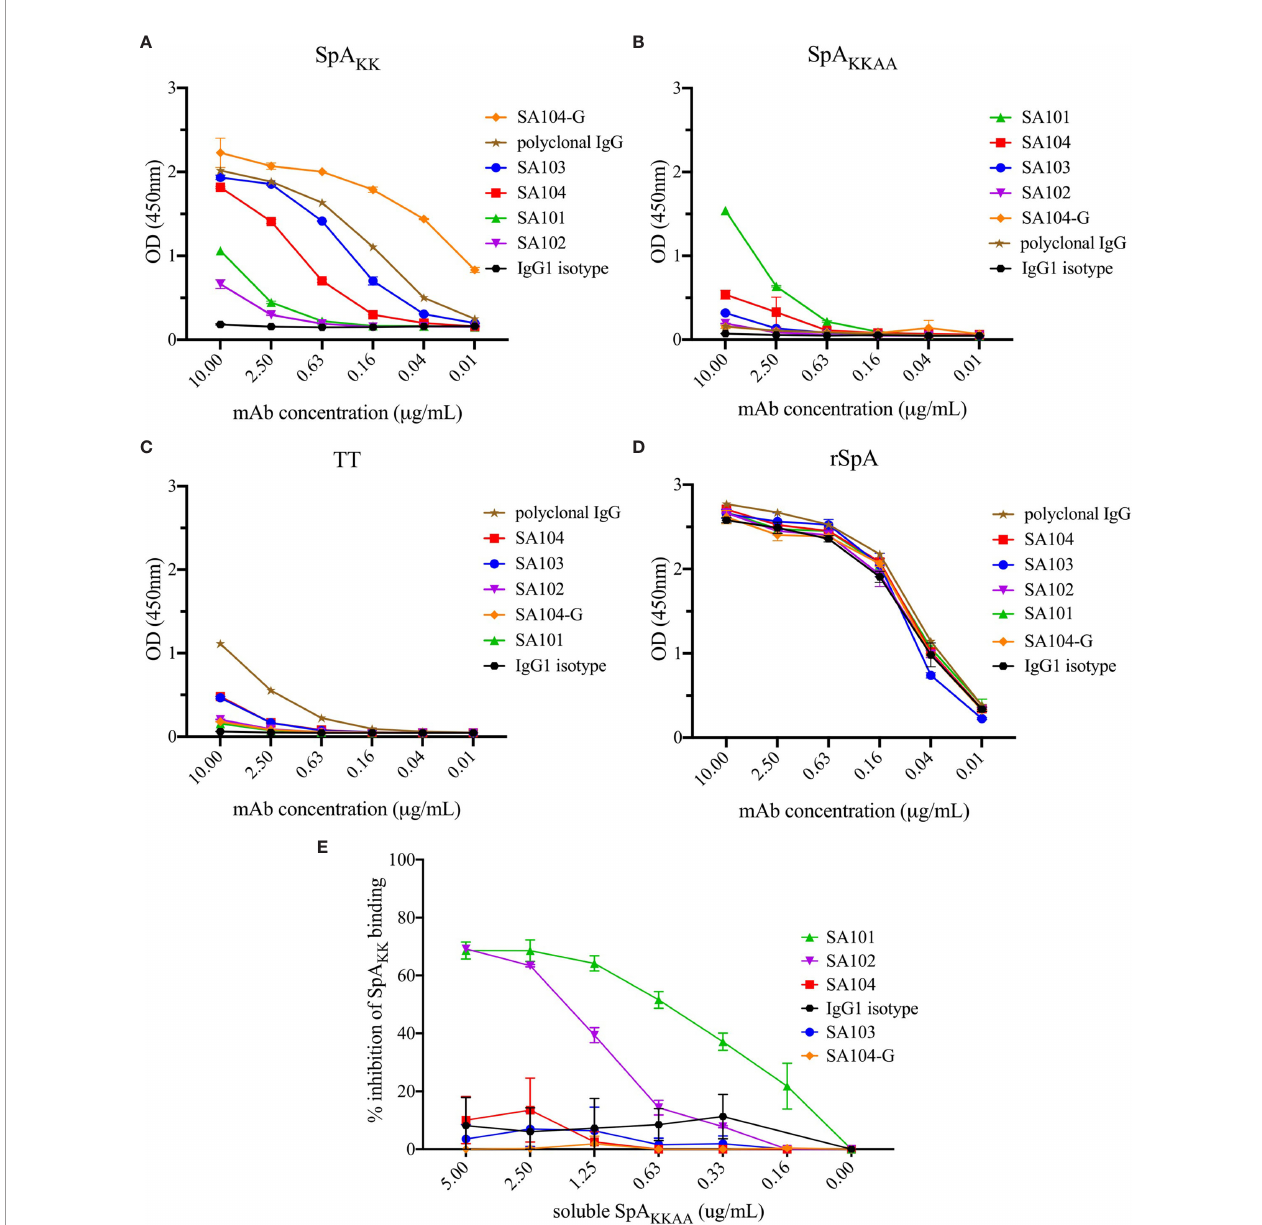
FIGURE 6 | Reactivity of monoclonal antibodies generated from the SpA KK -sorted memory B cells. Antibodies generated from identi fi ed sequences were tested for binding to SpA variants (A) SpA KK protein, (B) SpA KKAA protein and (D) WT rSpA. (C) Tetanus toxoid (TT) was used a control because a subset within polyclonal IgG puri fi ed from human serum recognizes this antigen, even though the mAbs do not. While the polyclonal IgG recognized tetanus toxoid due to the high prevalence of anti-TT antibodies in most individuals with up-to-date tetanus shots, the SpA KK -selected mAbs minimally bound the unrelated antigen. Each of these mAbs was tested at a range of concentrations from 10 to 0.01 µg/mL. (E) Inhibition of individual mAbs binding SpA KK by soluble SpA KKAA is shown as a percentage of total mAb binding reactivity at 1 µg/mL to SpA KK